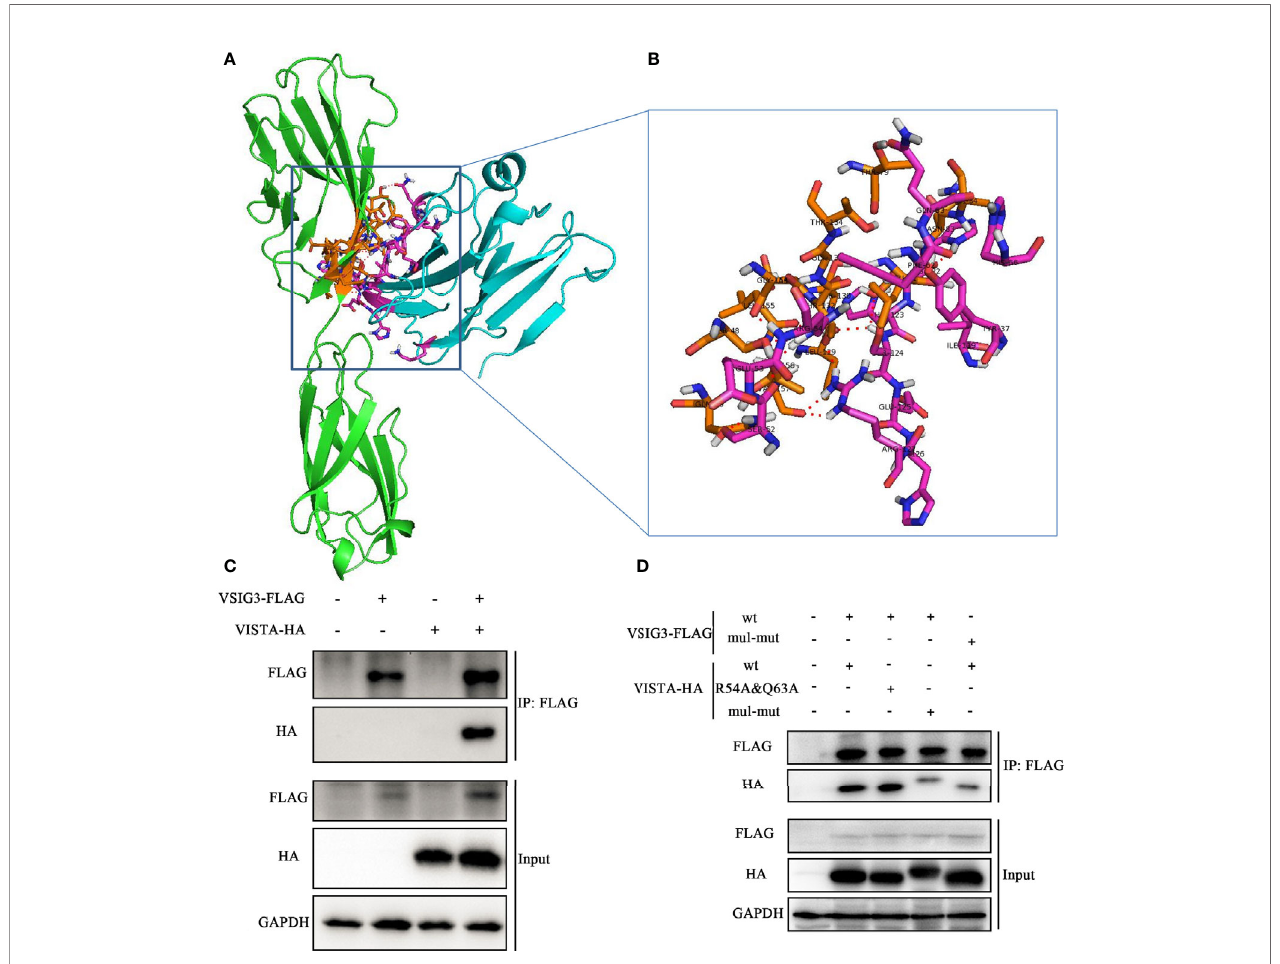
FIGURE 3 | Protein-protein docking for VISTA and VSIG3. (A) An overall map of the virtual docking of the human VISTA ECD (cyan) with the human VSIG3 ECD protein (green) based on the structures of hVISTA and hVSIG3. Key residues are depicted in stick representation (purple and orange). (B) Enlarged the schematic diagram of the binding site. (C) HEK293T cells were transfected with VSIG3-FLAG and VISTA-HA plasmids. Equal amounts of protein were immunoprecipitated with Anti-FLAG magnetic beads and immunoblotted with antibodies indicated. (D) Co-IP detected the interaction by multiple mutated amino acid epitope on VISTA and VSIG3. HEK293T cells were transfected with wild type (wt) or multiple point mutations (mul-mut) of VSIG3-FLAG or VISTA-HA plasmids. Equal amounts of protein were immunoprecipitated Anti-FLAG magnetic beads and immunoblotted with antibodies